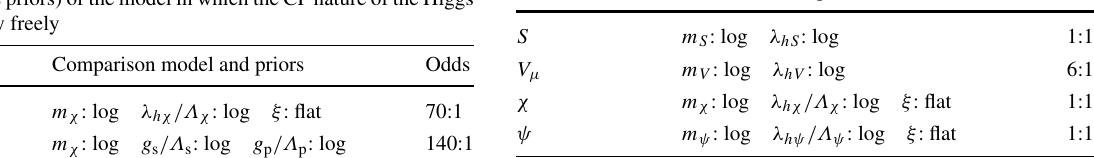
Table 9 Odds ratios against each singlet Higgs portal DM model with Z 2 symmetry, relative to the scalar model